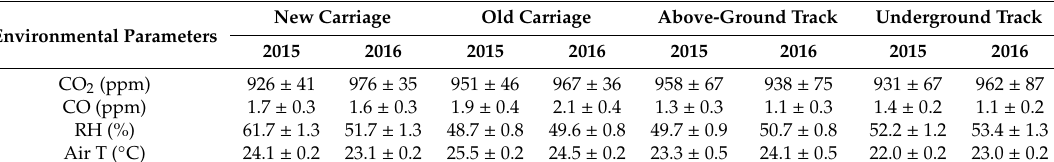
Table 3 The environmental parameters in metro carriage under different conditions (Mean ± S.E.). Table 3. The environmental parameters in metro carriage under di ff erent conditions (Mean ± S.E.). Environmental Parameters